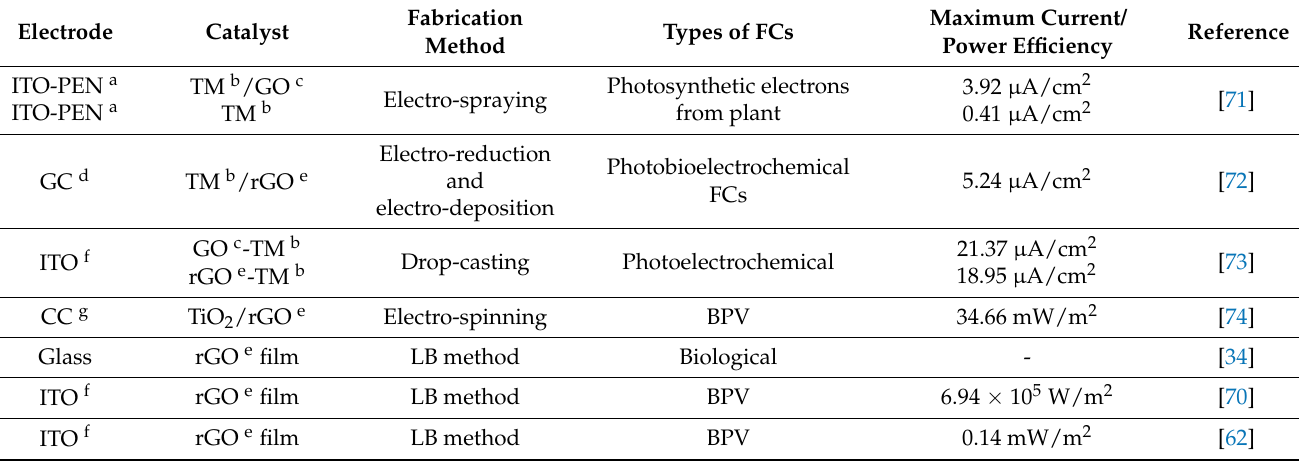
Table 1. Comparison of maximum current and power efficiency for different types of